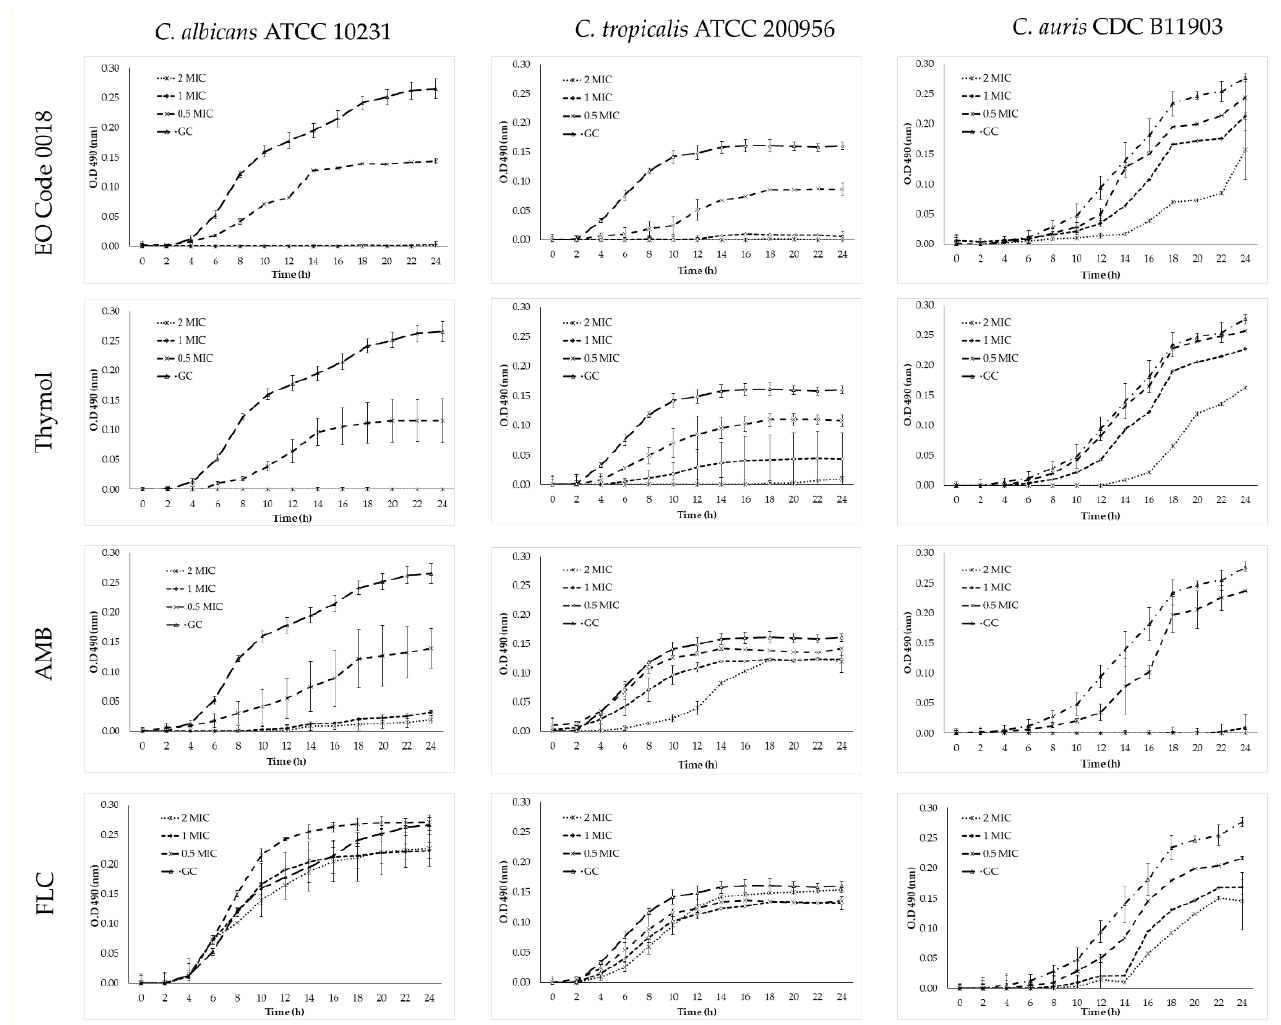
Figure 2. Time–kill curve plots for C . albicans ATCC 10231, C. tropicalis ATCC 200956, and C. auris CDC B11903 in the presence of the L. origanoides (thymol + p -cymene) chemotype (Code 0018) EO, thymol, AMB, and FLC.